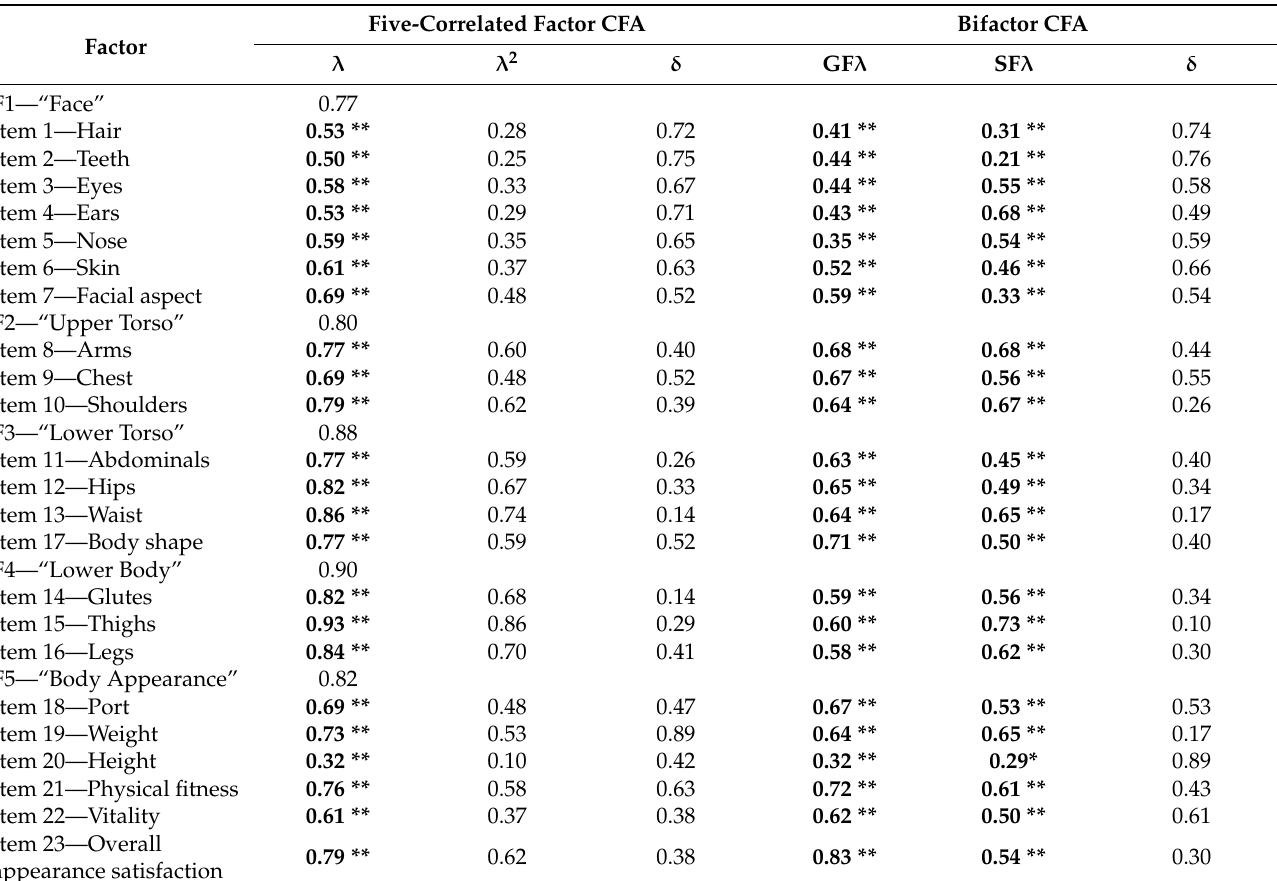
Table 3. Factor indicators of the five-correlated factor and bifactor CFA